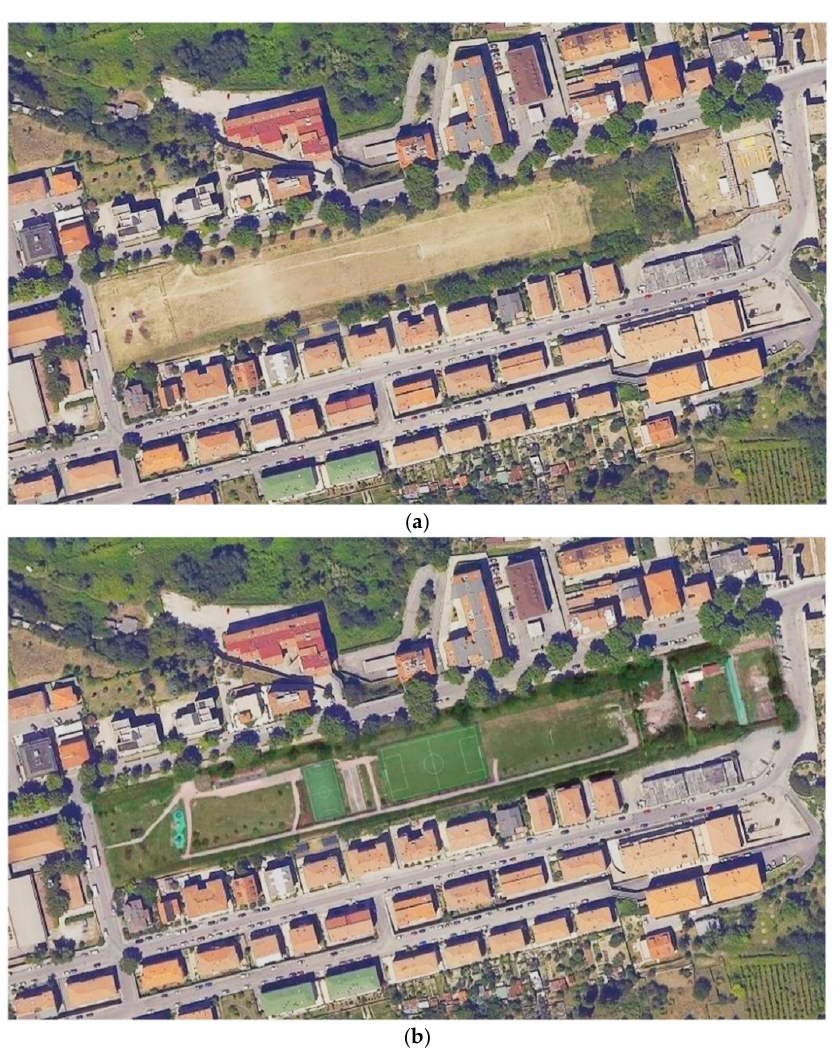
Figure 17. Ex Tiro a Segno. Before intervention at the top ( a ) and after intervention on the bottom ( b ).